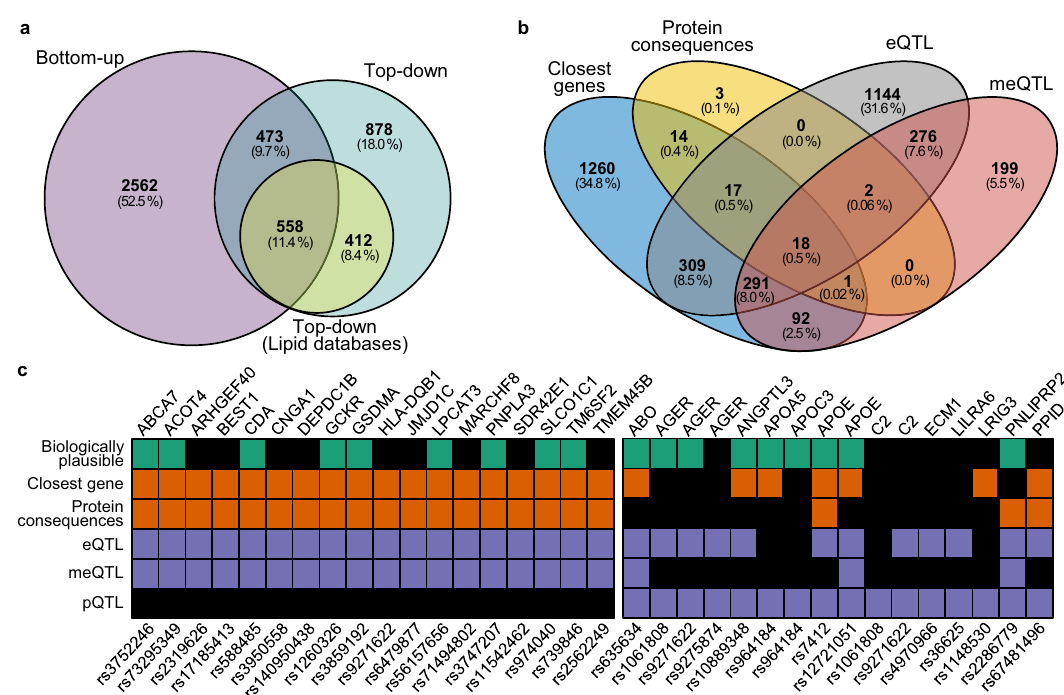
Fig. 4 Identi fi cation of putative causal genes using genetic prioritisation and knowledge-based approaches. Assignment of putative causal genes was performed using the ProGeM framework, incorporating genetic-based prioritisation (bottom-up), and biological knowledge-based approaches (top-down). a Venn diagram showing the number of loci with annotations for candidate genes using the distinct approaches and the overlap. Top-down annotations were divided into lipid-speci fi c databases and generic databases. b Venn diagram of distinct genes identi fi ed in genetic-based prioritisation analysis. c Summary of putative causal genes with overlapping annotations for closest gene, protein consequences, eQTL and meQTL (left). Summary of putative causal SNP-gene pairs for which pQTL evidence was identi fi ed (right). eQTL expression quantitative trait loci, meQTL methylation quantitative trait loci, pQTL protein quantitative trait